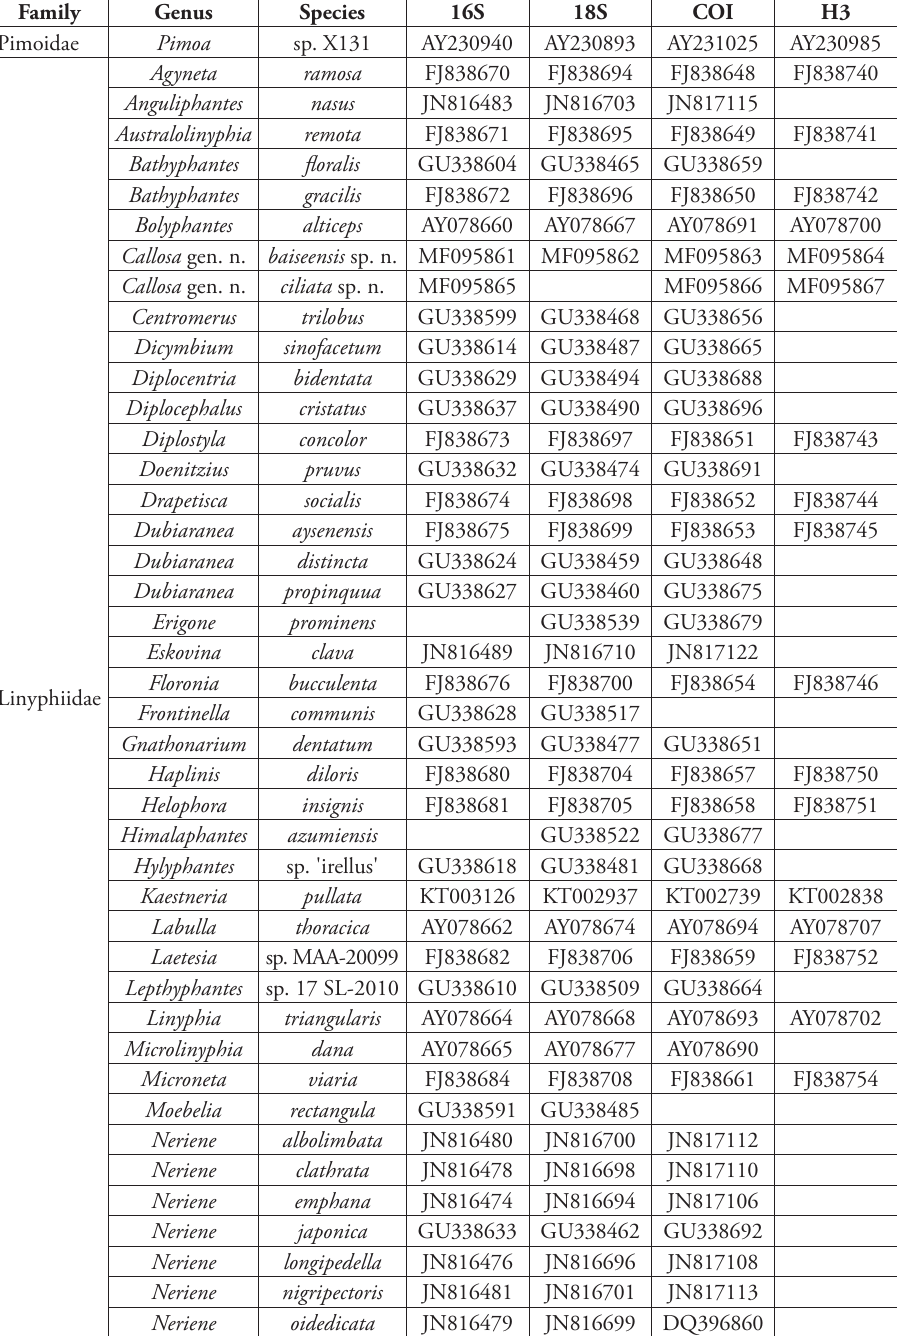
Table 1. DNA data information of species included in the phylogenetic analysis